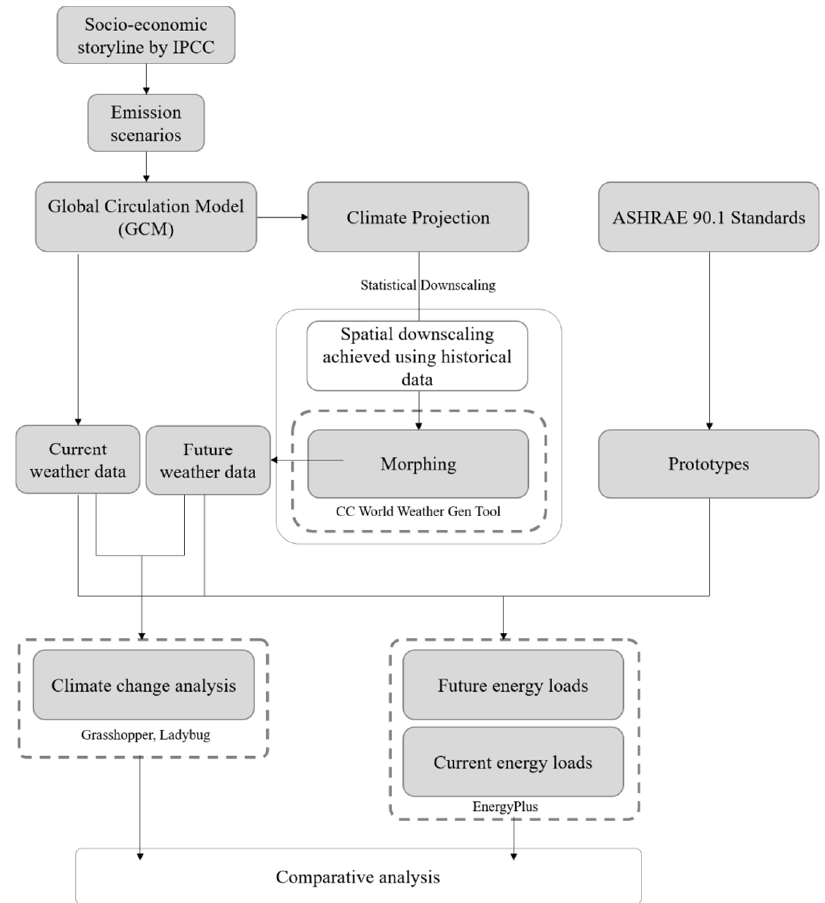
Figure 5. Research